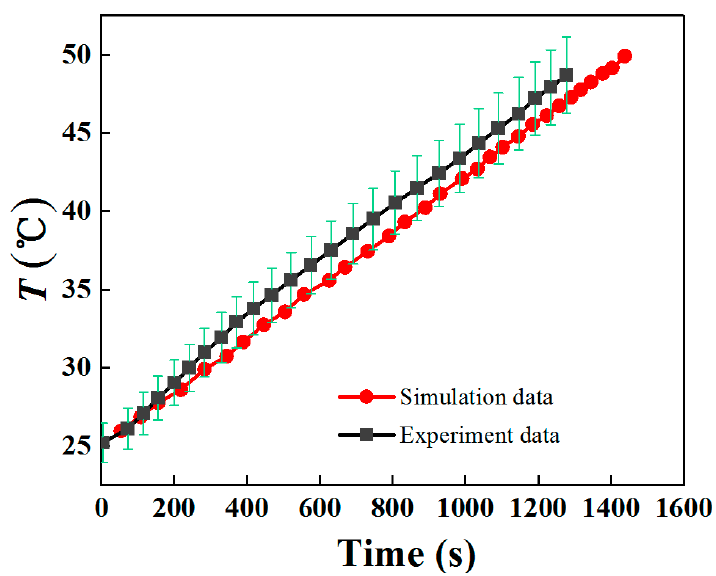
Figure 4. Model verification (with 5% error bars) [34].